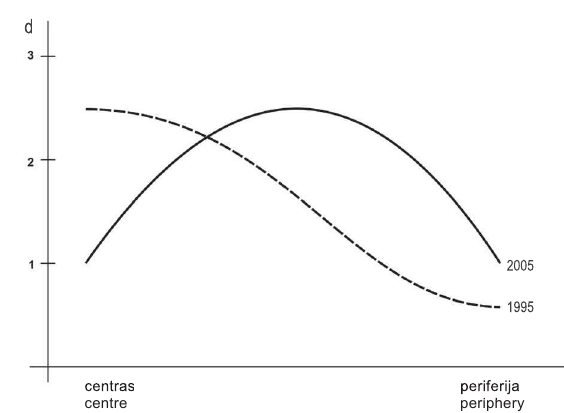
Fig 4 . Distribution of Vilnius residents above 60 and